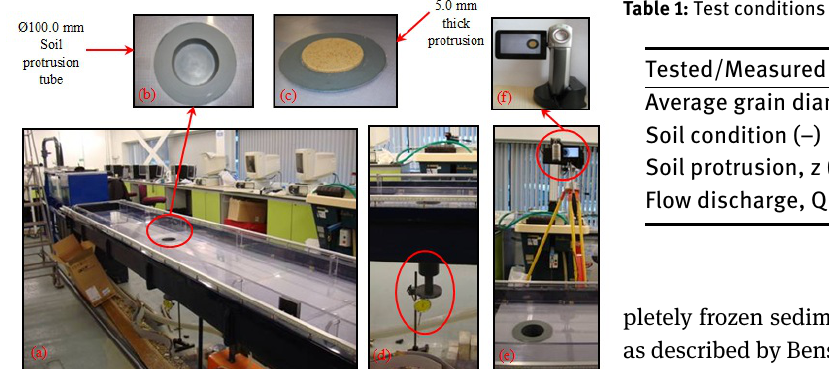
Table 1: Test conditions used in the experiments